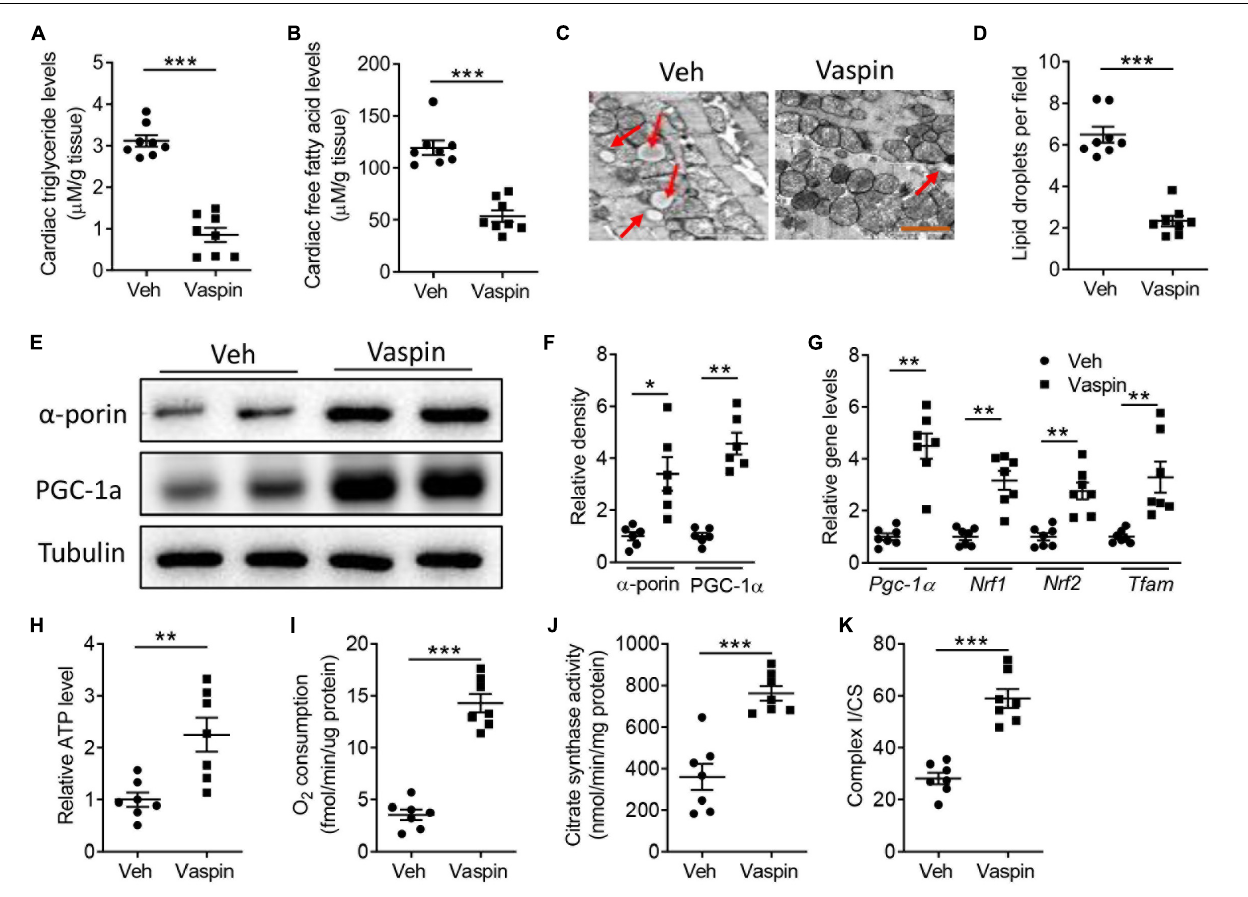
FIGURE 3 | Vaspin increases cardiac mitochondrial biogenesis and activities in A-ZIP/F-1 lipoatrophic mice. Sixteen-week-old A-ZIP/F-1 mice were treated with recombinant vaspin protein (100 µ g/mouse) by an osmatic pump for 8 weeks. (A,B) The cardiac levels of triglyceride (A) and free fatty acid (B) . (C,D) The representative images of cardiac mitochondria (C) and quantitative analysis of lipid droplets (D) . (E,F) Western blot analysis of cardiac α -porin and PGC-1 α (E) , and quantitative analysis of relative density (F) . (G) Real-time quantitative analysis of cardiac mitochondrial genes, including Pgc-1 α , Nrf1 , Nrf2 , and Tfam . (H–K) Measurement of relative ATP production (H) , oxygen consumption (I) , citrate synthase activity (J) , and ratio of complex I/CS (K) in extracted cardiac mitochondria. Results are shown as mean ± SEM, and n = 6–8 mice/group. * p < 0.05, ** p < 0.01, *** p <